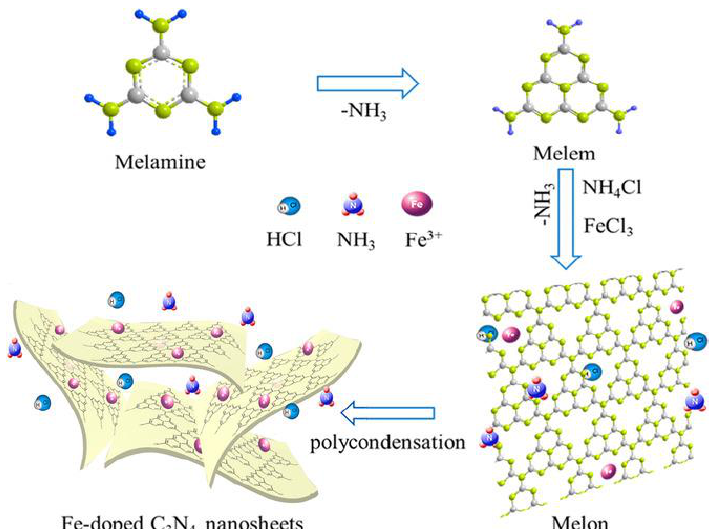
Figure 8. Schematic illustration of the synthesis process of Fe-doped g-C 3 N 4 nanosheets. Reprinted with permission from Ref. [68] . Copyright 2017 John Wiley and Sons.